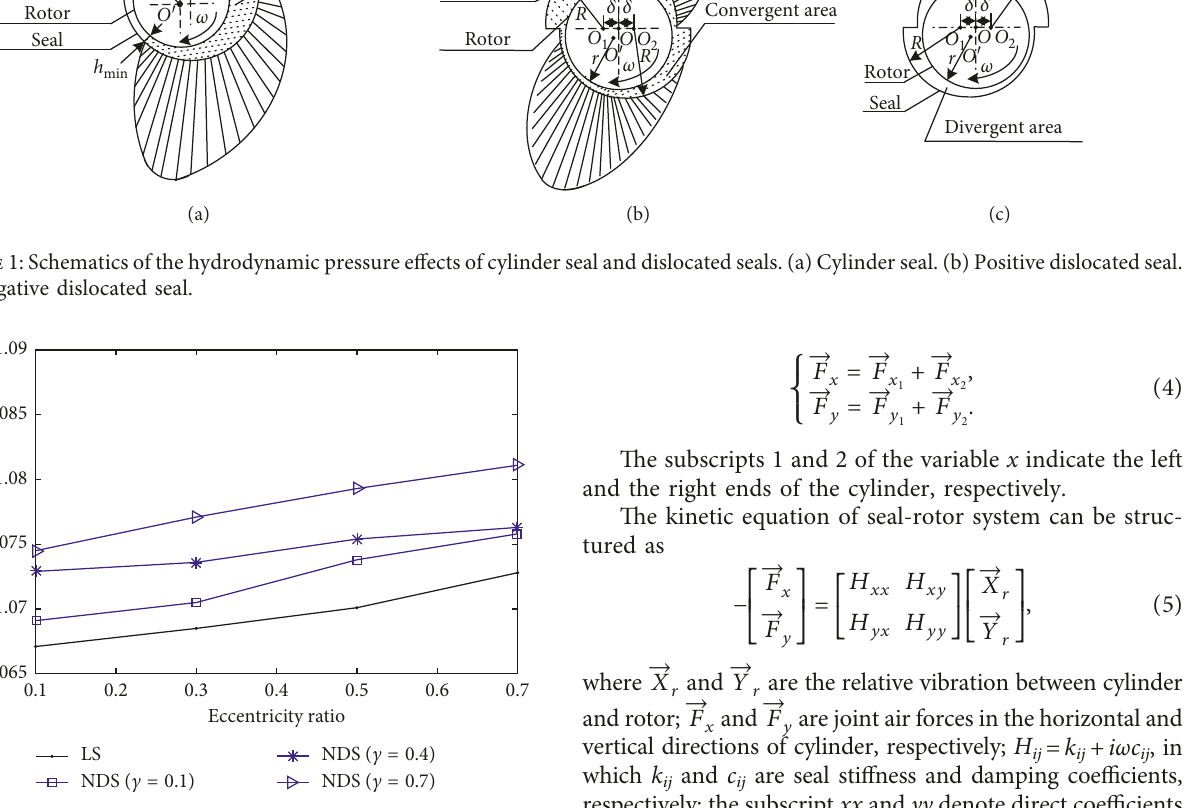
Figure 2: Effect of eccentricity on seal leakage characteristics.